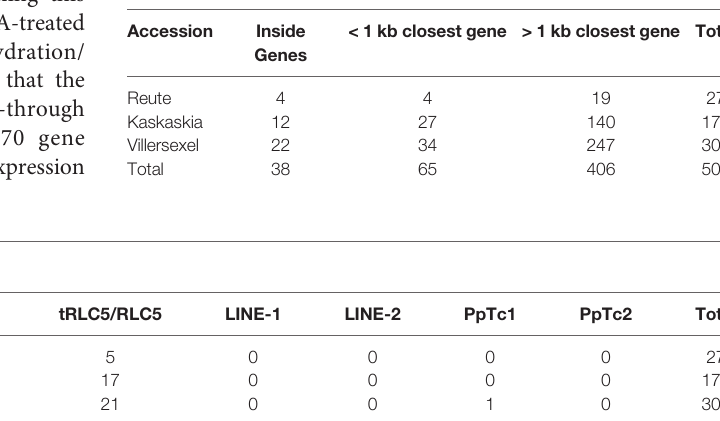
TABLE 3 | Distance of polymorphic TE insertions to